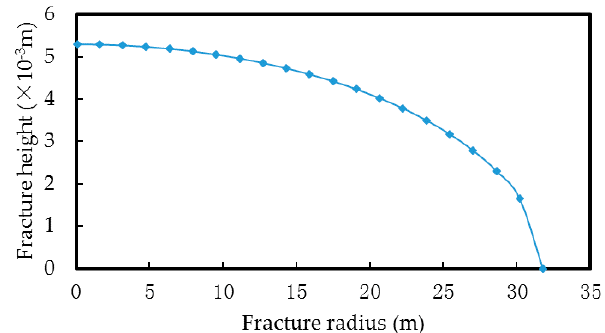
Figure 6. Relationship between fracture height and fracture radius.